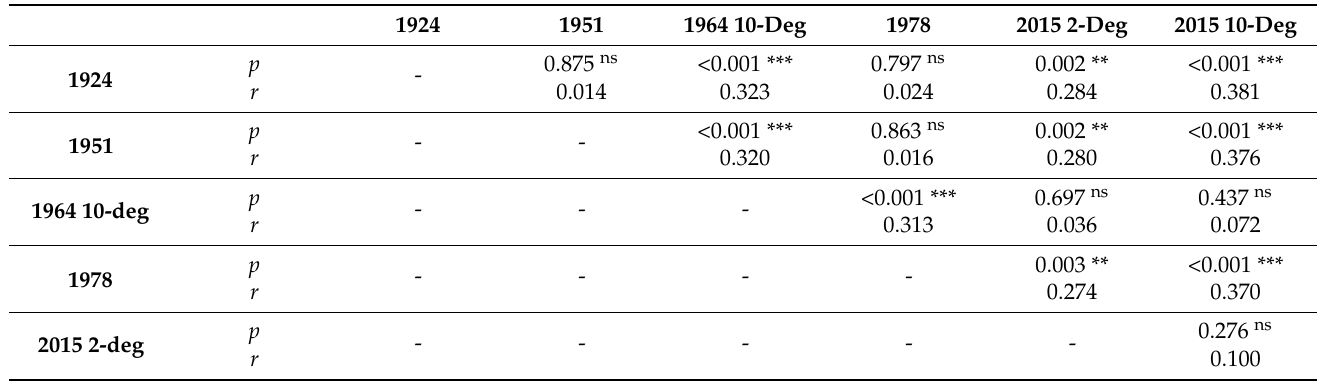
Table 1. Rank sum test and effect size for LER ( p -value and effect size ( r )).